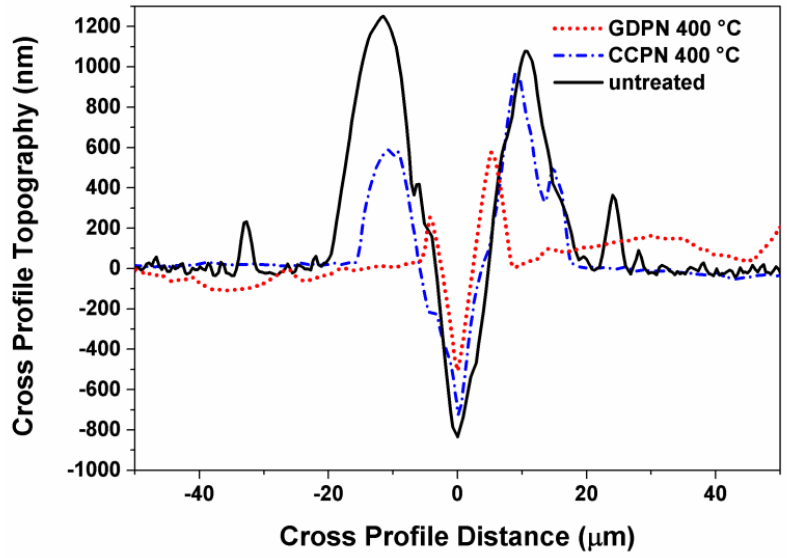
Figure 17. Cross-section topographies taken at the grooves’ middle regions, corresponding to 200 mN of applied load.